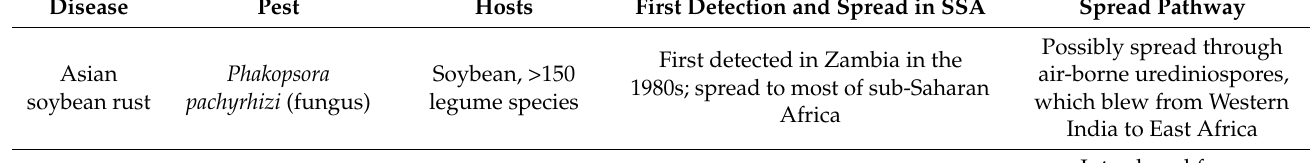
Table 1. Some of the most economically important disease outbreaks, caused by pests introduced into sub-Saharan Africa (SSA). Disease Pest Hosts First Detection and Spread in SSA Spread